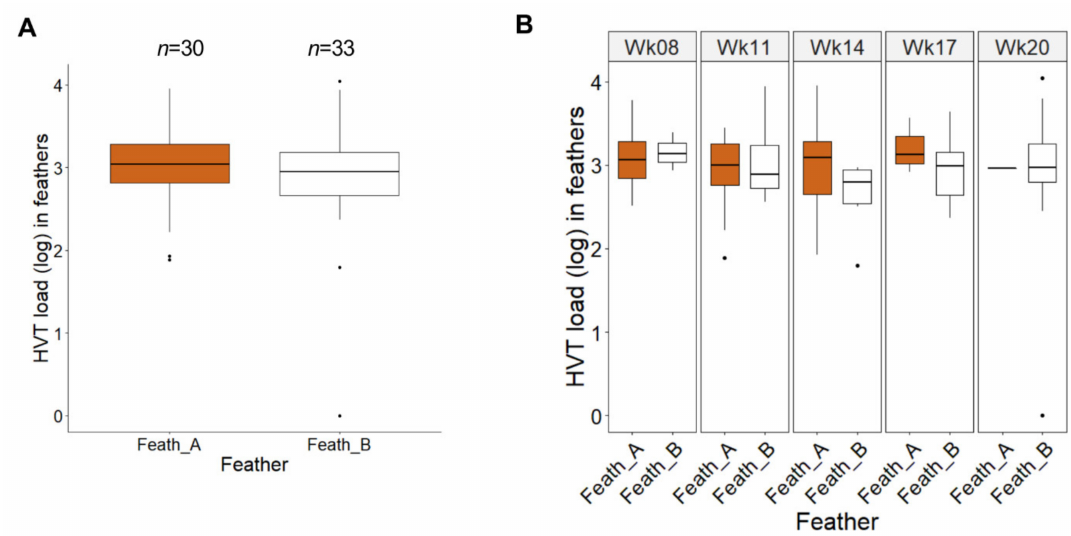
Figure 4. Comparison between HVT load in pigmented and non-pigmented feathers in vitiliginous SL chickens from week 8 to 20. Pigmented feathers (Feath_A in brown); non-pigmented feathers (Feath_B in white). The HVT load unit is HVT genome copy number per million cells. ( A ) HVT loads across time. Data are shown in Tukey boxes with the log medians visible as thick horizontal bars (3.037 for Feath_A, 2.951 for Feath_B). The two boxplots highly overlap indicating no or very low di ff erences in HVT loads between pigmented and non-pigmented feathers in SL. ( B ) HVT loads at individual times. Data are shown in Tukey boxes as above. No significant di ff erences in HVT loads were observed between pigmented (Feath_A) and not pigmented feathers (Feath_B) (all adjusted p -value > 0.9; exact Wilcoxon test with a Holm correction for multiple